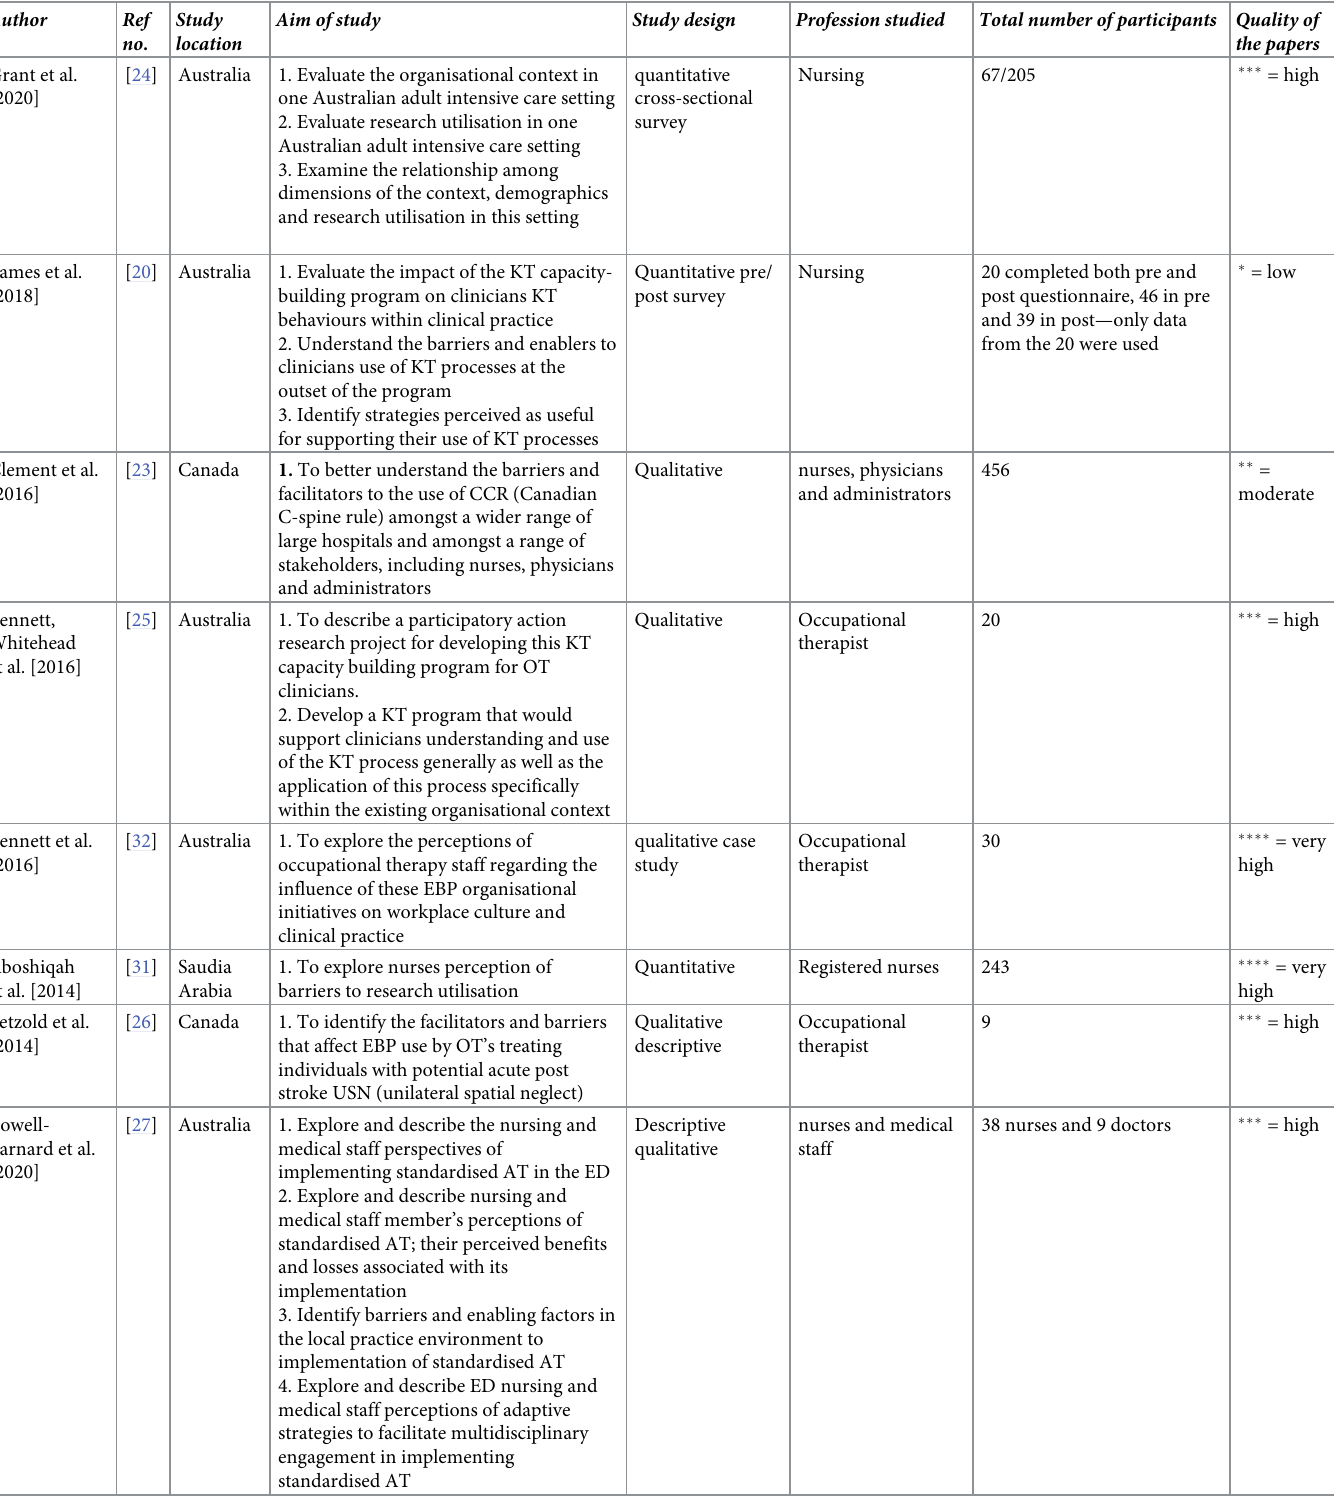
Table 2. The study characteristics of the included articles in the review and quality